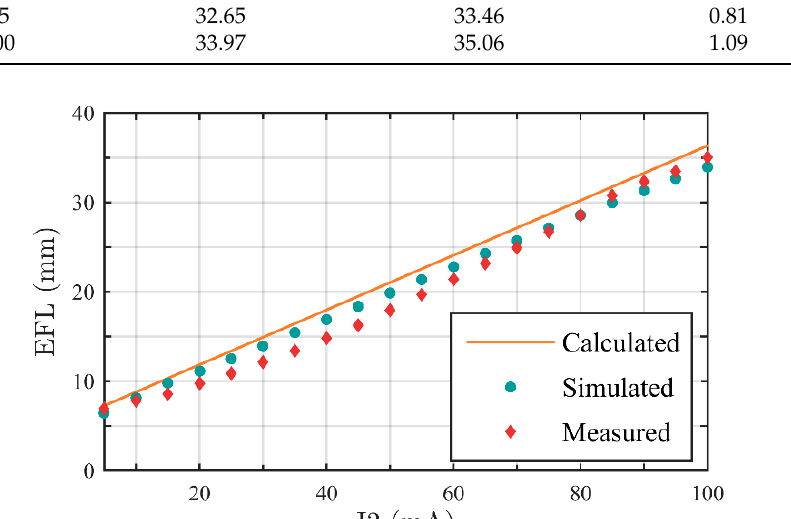
Figure 9. EFL comparison among calculated value, simulated value, and measured value.